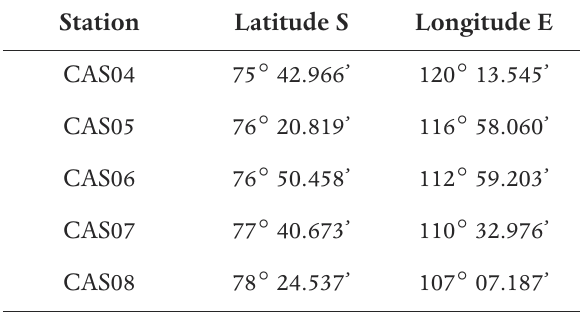
Table 2. Locations of profile CASE-IPY